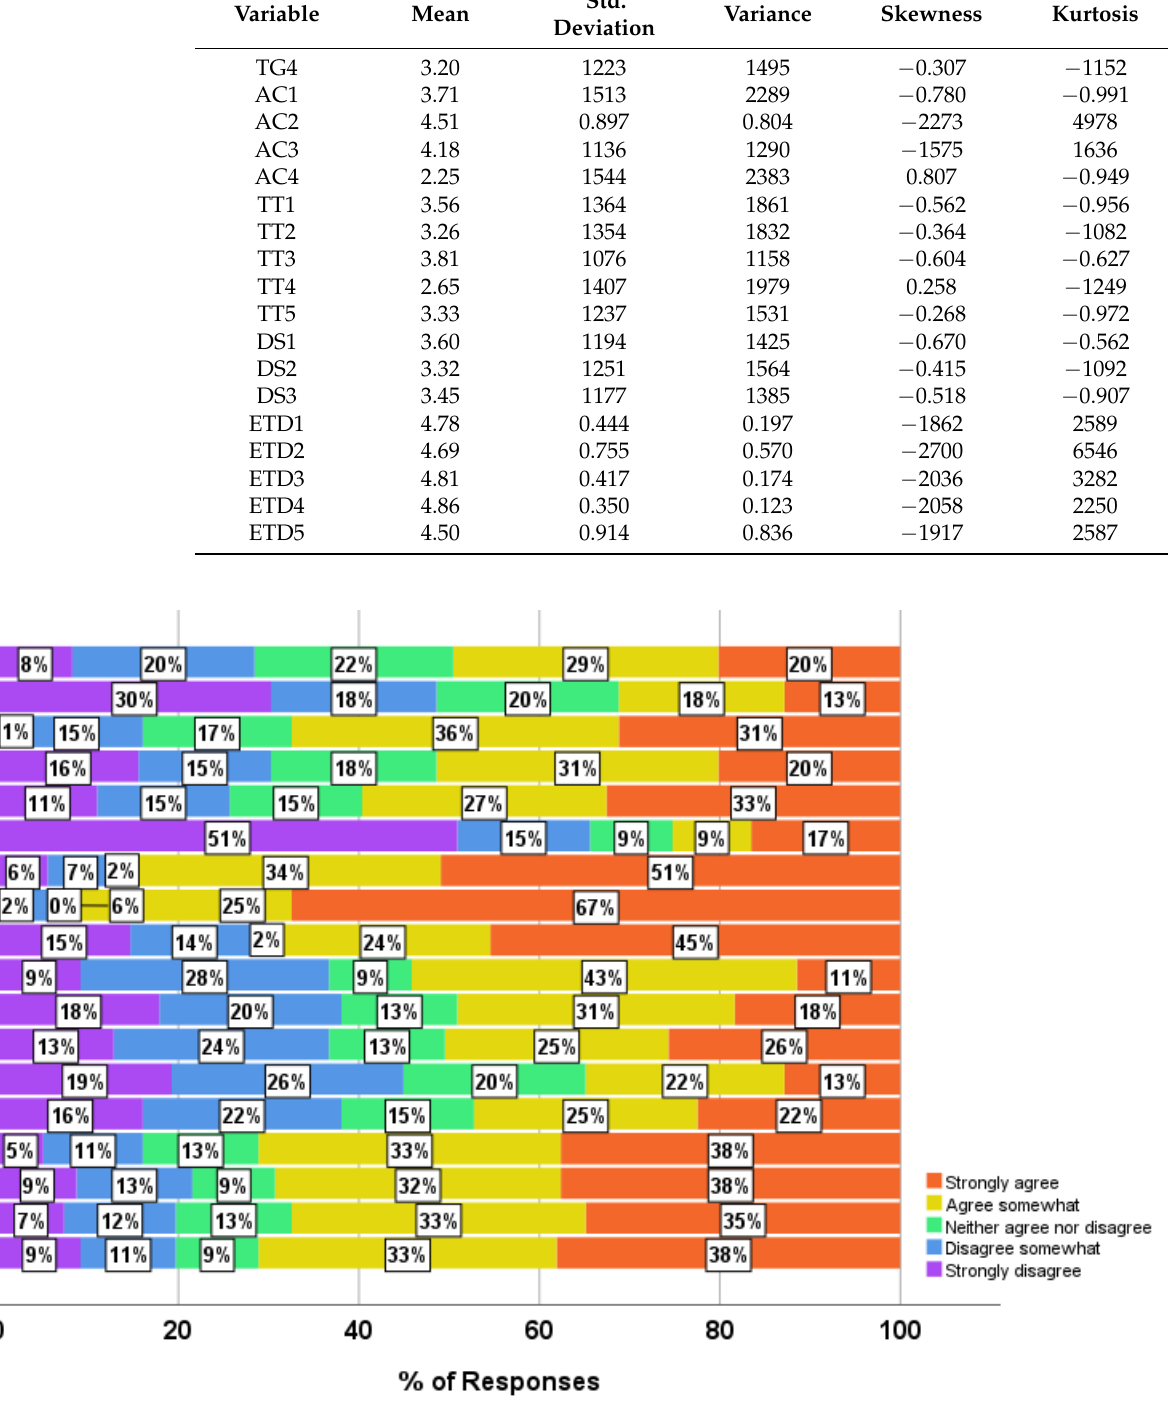
Figure 2. Distributions of survey responses. TT: Trust in IoT devices, AC: Acceptance of IoT devices, TG: Trust in city authorities, PU–Perceived usefulness.